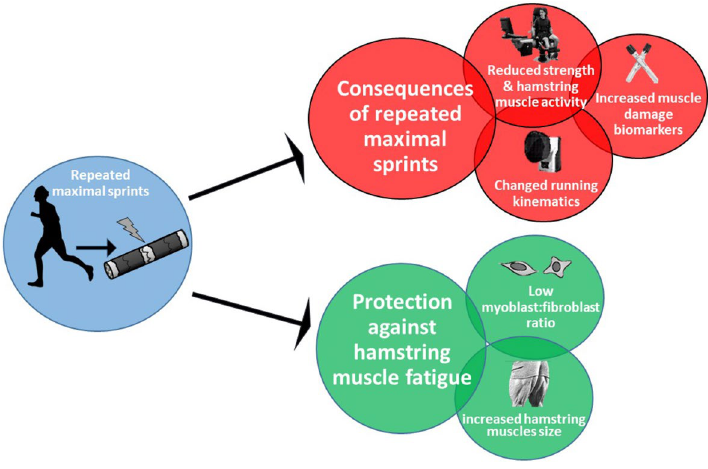
Figure 6. Summary figure describing the main findings of the current